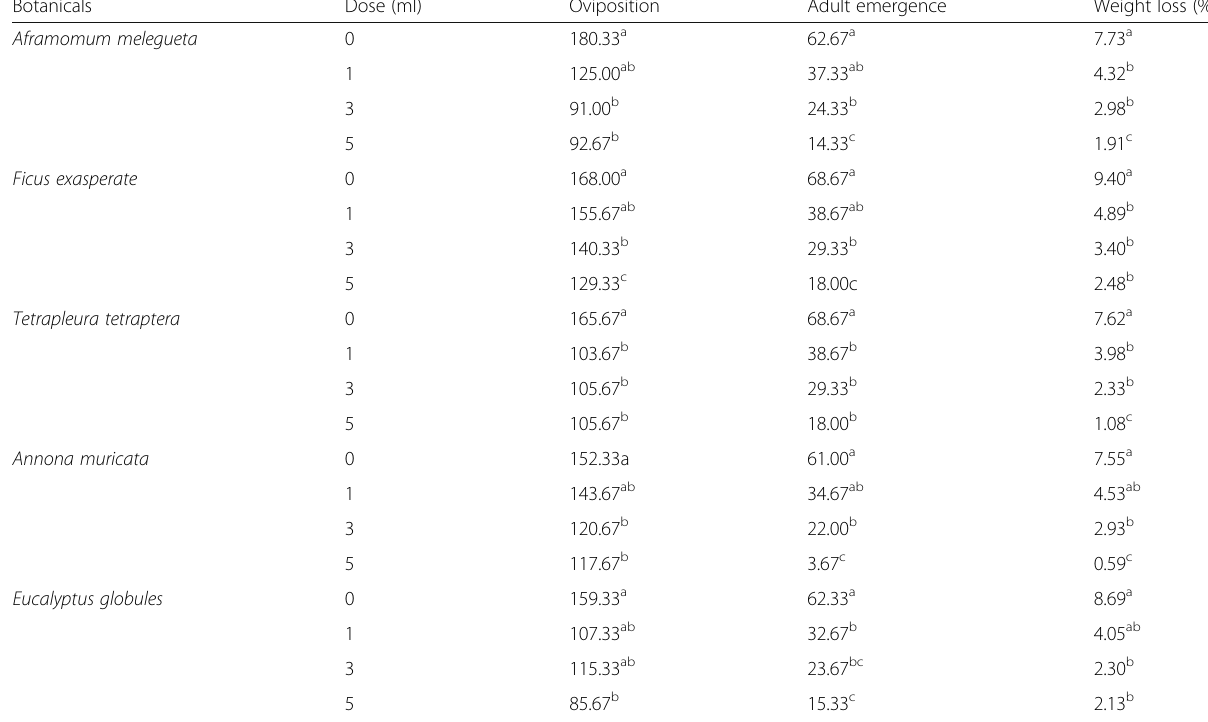
Table 3 Effects of essential oils on the insect biology and seed weight loss by Callosobruchus maculatus Botanicals Dose (ml) Oviposition Adult emergence Weight loss (%) Aframomum